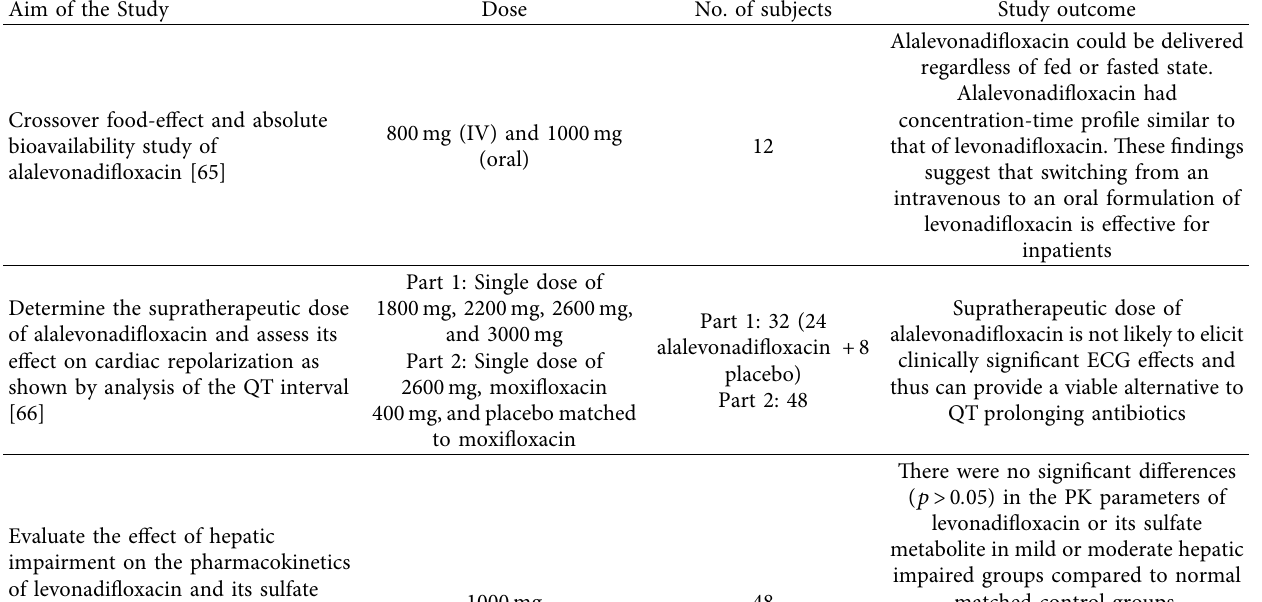
Table 4: Summary of clinical studies with levonadifloxacin and alalevonadifloxacin. Aim of the Study Dose No. of subjects Study